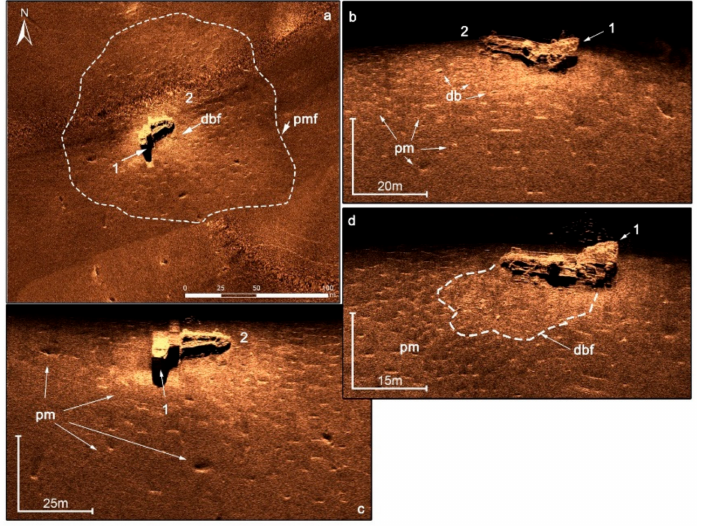
Figure 9. ( a ) Regional 100 kHz sonograph showing the “old iron” wreck and its environment, ( b – d ) 500 kHz sonographs showing the main structural components of the “old iron” wreck (1: bow, 2: stern) (dbf: debris field, db: wreck debris, pm: pockmarks, pmf: pockmark